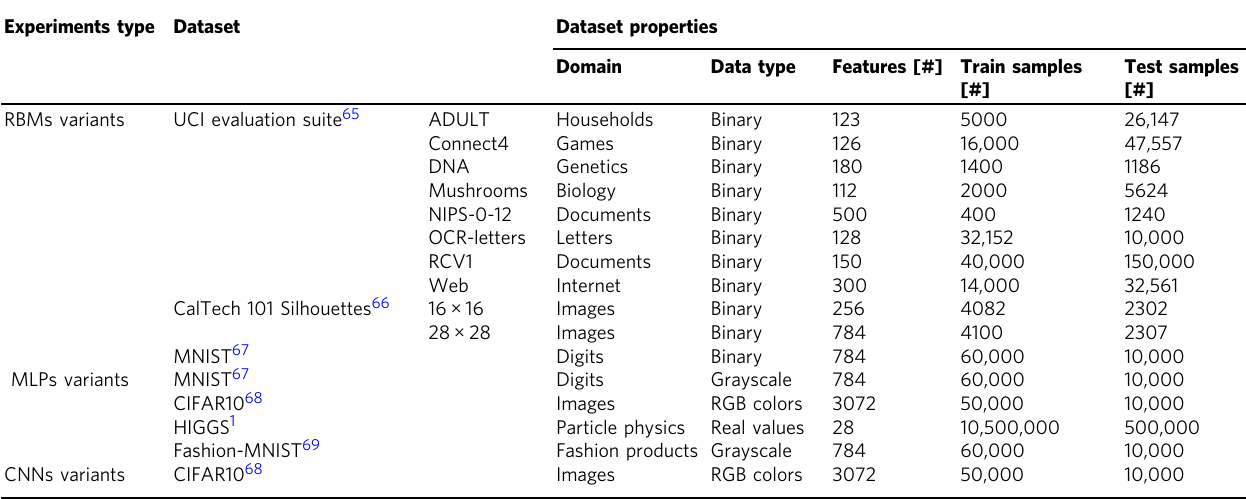
Table 1 Datasets characteristics Experiments type